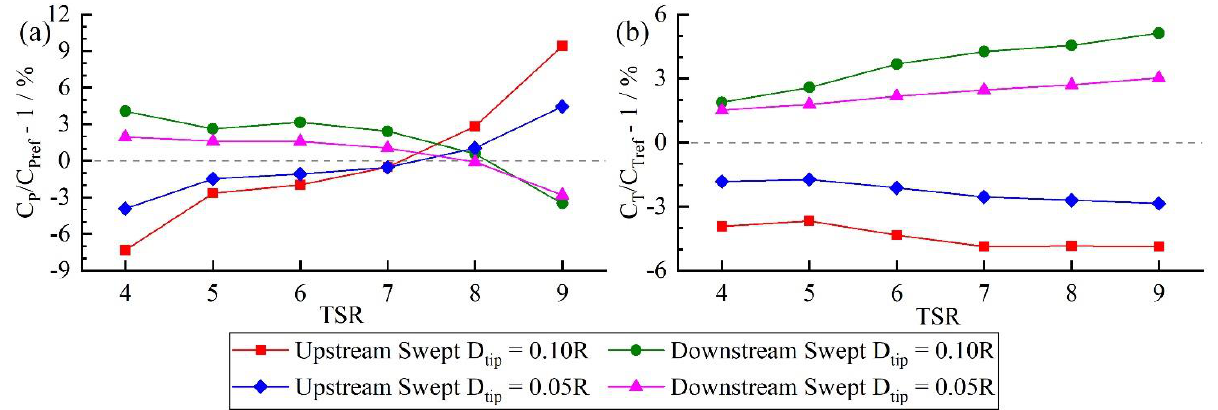
Figure 15. Variation owing to swept blades with different d tip in C P and C T ; (a) for C P , and (b) for C T .